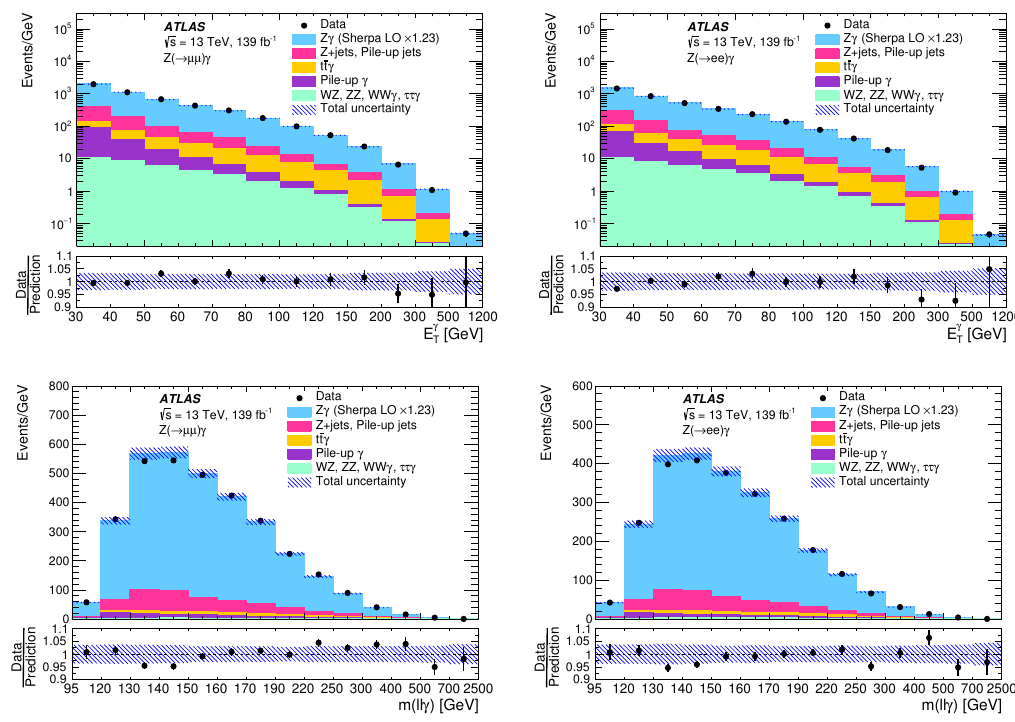
Figure 5 . Distributions of (top) E (cid:13) and (bottom) m ( ‘‘(cid:13) ) for the (left) (cid:22) + (cid:22) (cid:0) (cid:13) and (right) e + e (cid:0) (cid:13) T signal regions. The number of candidates observed in data (black data points) is compared with the sum of the signal predicted using the Sherpa LO MC signal sample (including a normalisation factor of 1.23) and the estimated background contributions. The lower section of each plot shows the ratio of the observed distribution to the sum of the predicted signal and estimated background. The error bars on the observed distribution and on the ratio of the observed and expected distributions show the statistical uncertainty due to the number of observed events. The hatched bands represent the sum in quadrature of the uncertainty in the background estimation, the statistical uncertainty in the MC signal prediction, and the experimental systematic uncertainty, excluding the uncertainty in the integrated